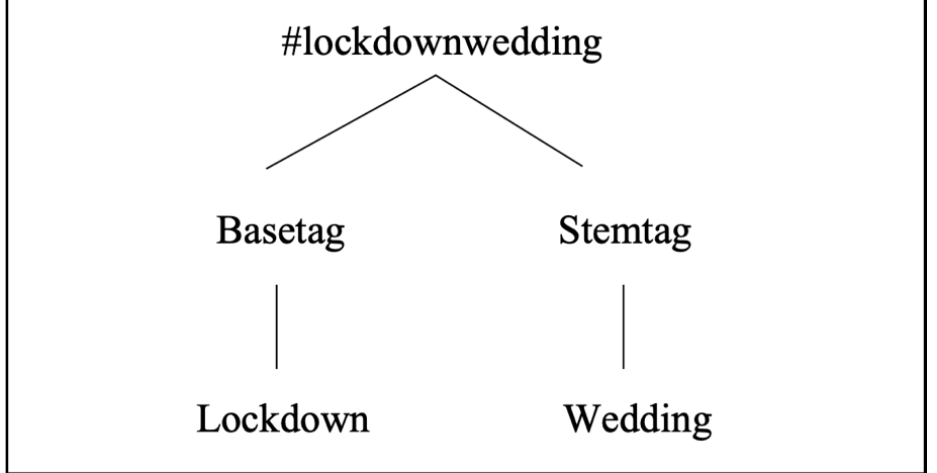
Figure 3. Hashtags and social events